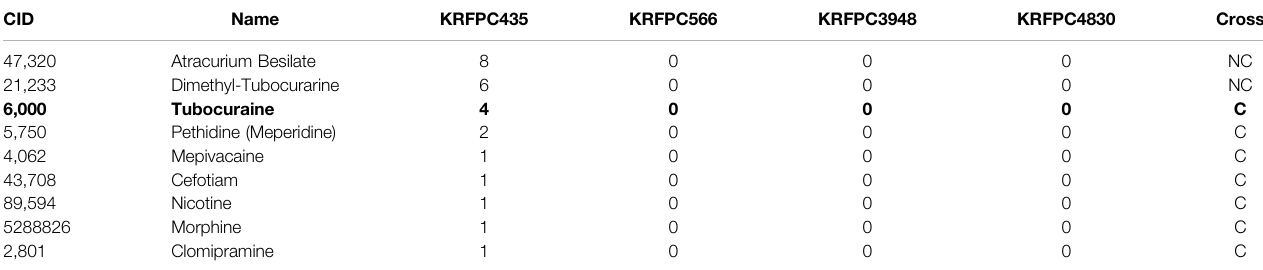
TABLE 8 | Compounds from the database similar to Tubocuraine (CID (cid:1) 6,000, in bold) in terms of the four descriptors of the fi nal model. The “ Cross ” column contains the actual placental transfer class (C or NC).